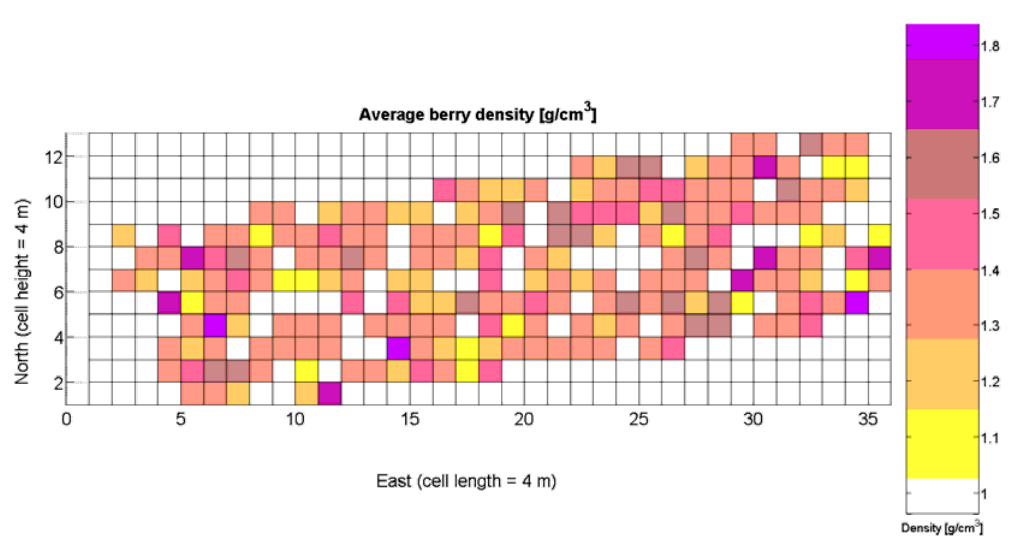
Figure 15. CB map of average berry density (g/cm 3